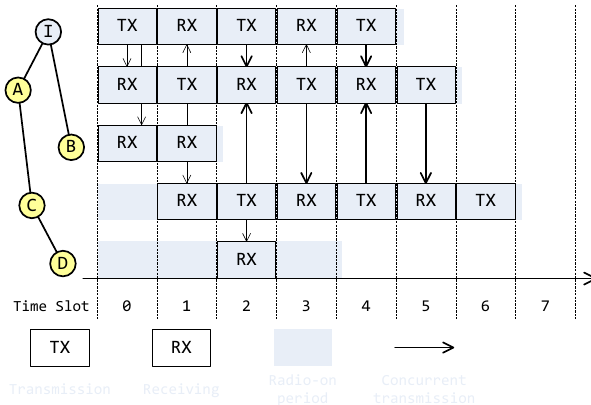
Figure 5. Nodes self-determine the actions based on the results of their learning phase. This example shows the final state after all sensor nodes (in light yellow) have completed their learning phase. Node A and C choose action 3 to ensure the reliability, while node B and D act as absorbing nodes. Node D hears nothing in the fourth time slot, since there is no neighboring node on the same or on a lower